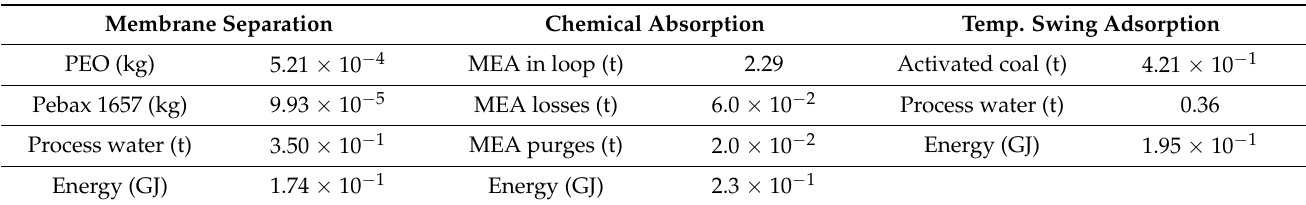
Table 6. Main material and energy flows associated to the use phase (CO 2 separation) of the CC facilities (per functional unit). Membrane